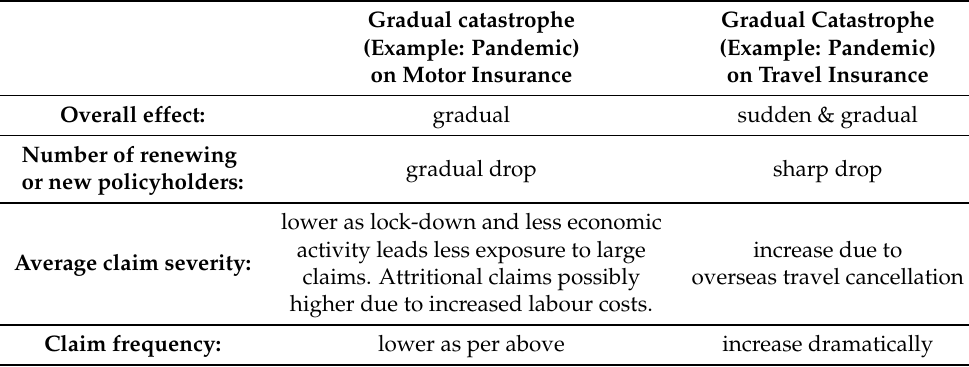
Table 4. Summary of effects of pandemics on motor and travel